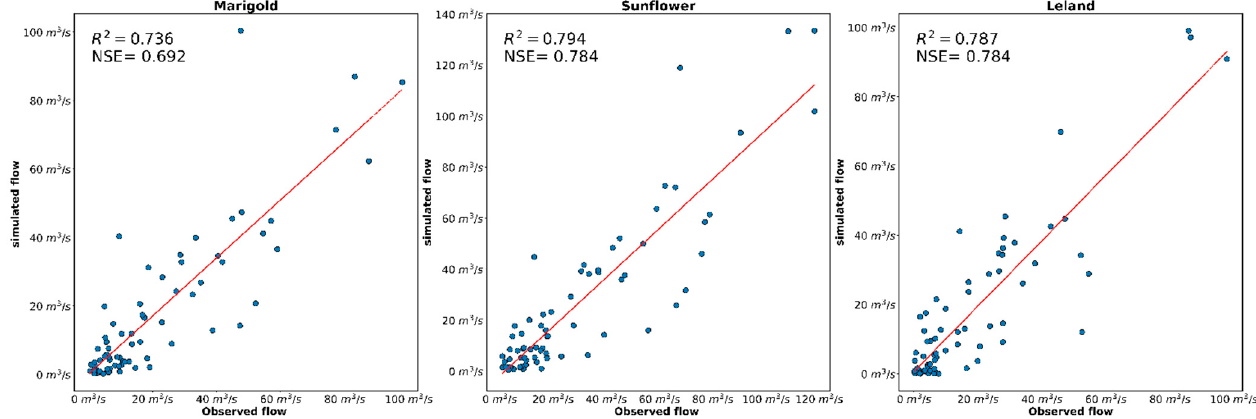
Figure 4. Comparisons of observed vs. simulated flow during model calibration and validation at Marigold, Sunflower, and Leland gauge stations.